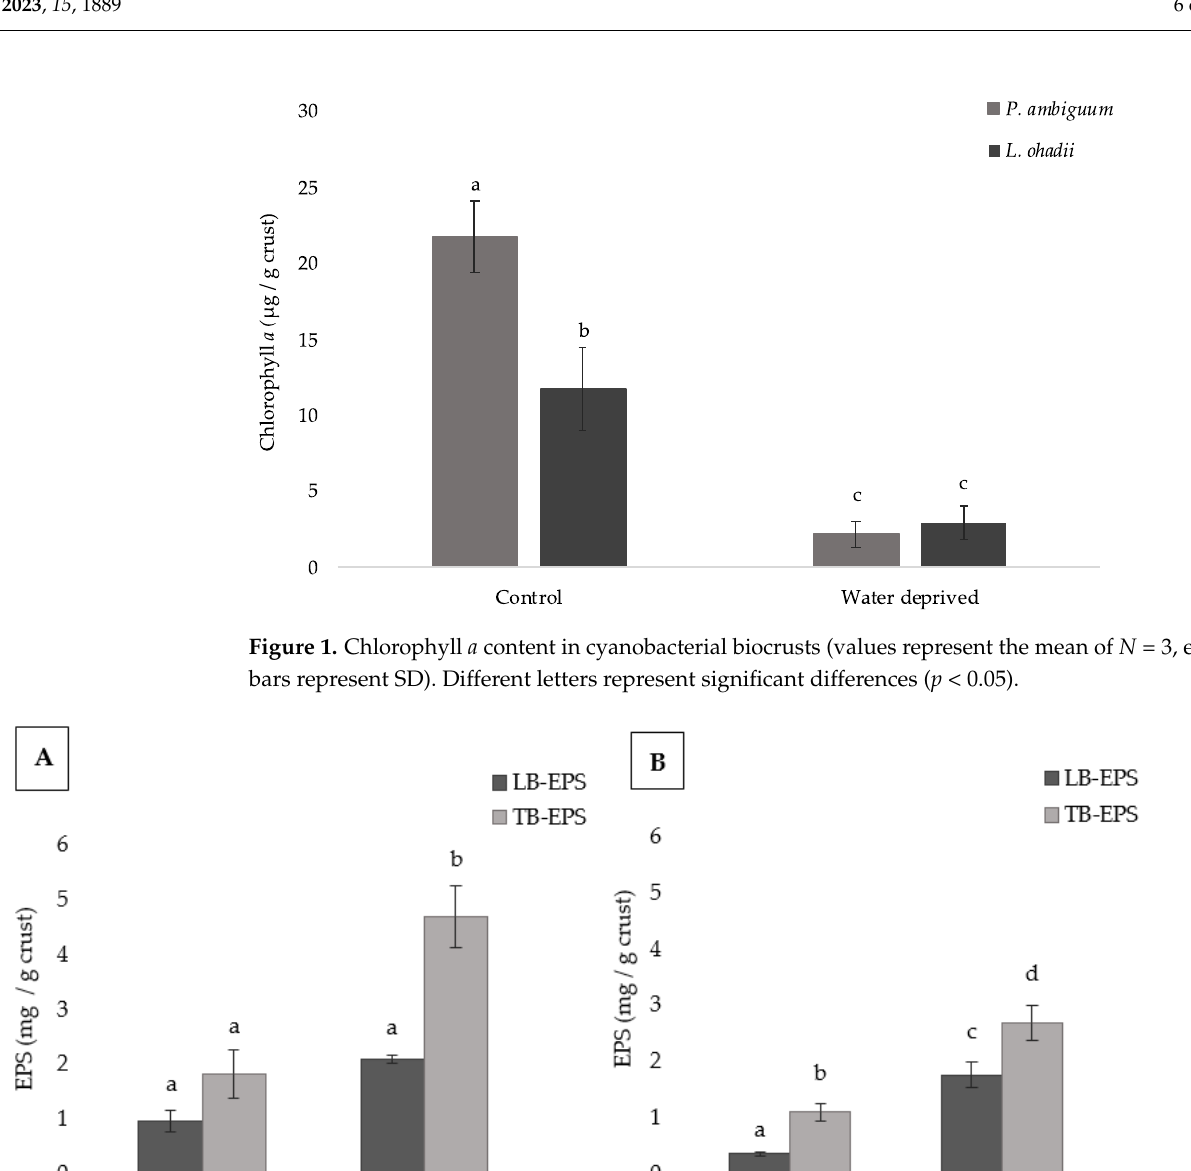
Figure 2. EPSs contents in P. ambiguum ( A ) and L. ohadii ( B ) biocrusts (values represent the mean of N = 3, error bars represent SD). Different letters represent significant differences ( p < 0.05) in each graph.